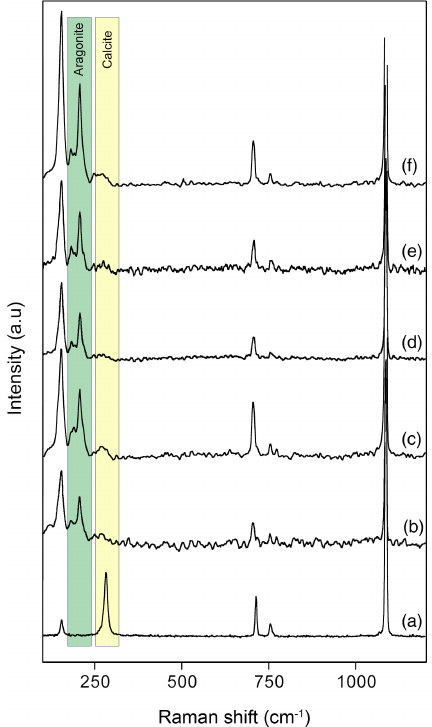
Figure 3. Specific Raman shift of a calcite standard (a) and a biogenic aragonite standard (b) and skeletal material from con- trol (c) , high temperature (d) , high p CO 2 (e) , and high tempera- ture + p CO 2 (f) treated Acropora spicifera coral recruits. The ∼ 205 peak specific to aragonite is highlighted in green and the ∼ 281 peak specific to calcite is highlighted in